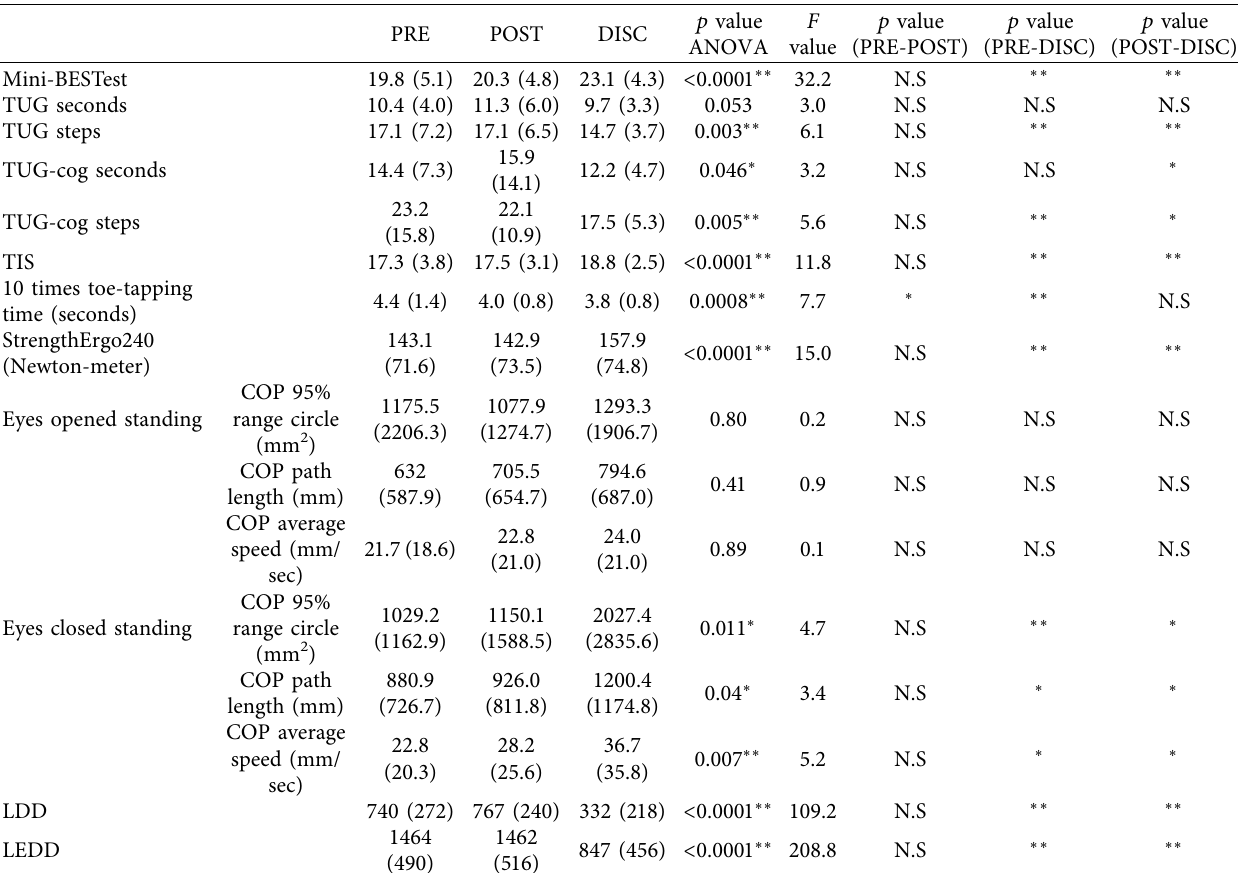
Table 2: Results of post-operative rehabilitation with